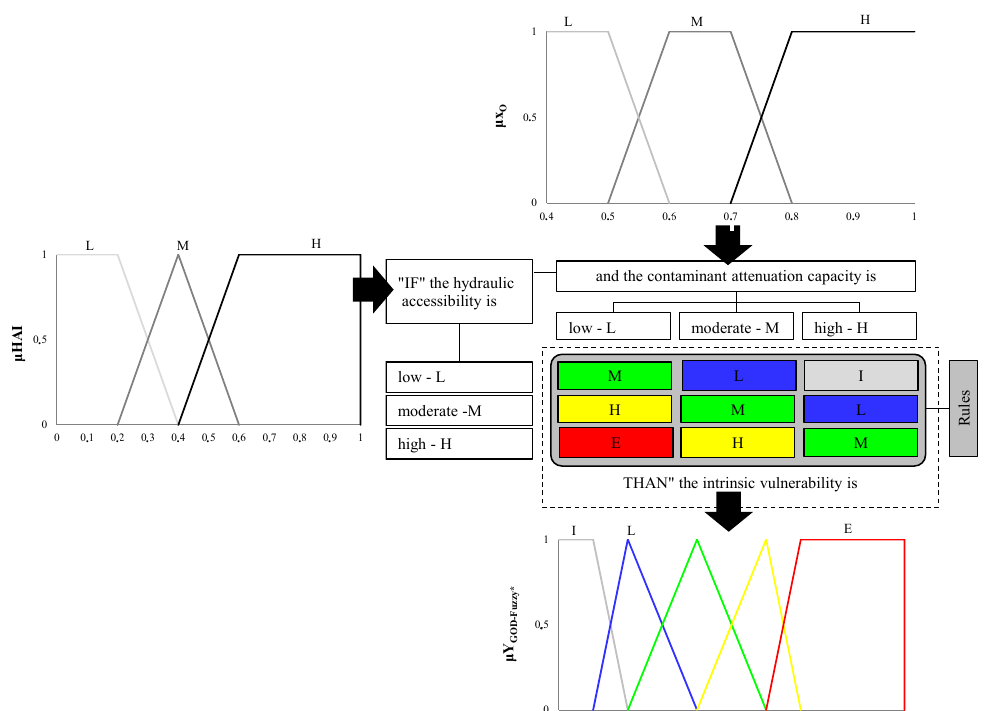
Figure 2. FIS for assessing the intrinsic vulnerability degree by Y GOD-Fuzzy *. GOD—groundwater hydraulic confinement, overlaying strata, and depth to groundwater table.